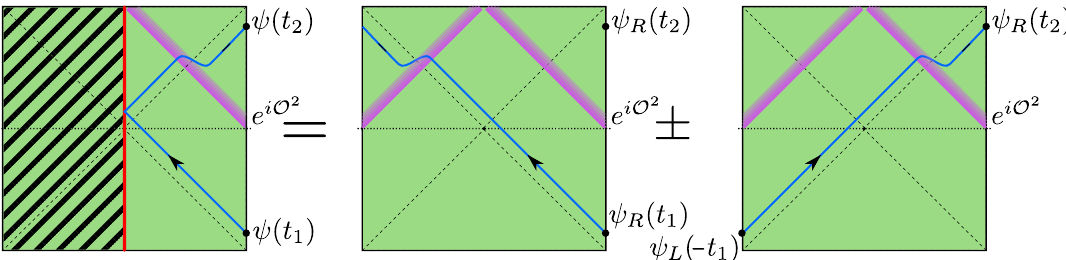
Figure 6 . The commutator between ψ ( t 1 ) and ψ ( t 2 ) is expected to be significantly enhanced due to turning on the